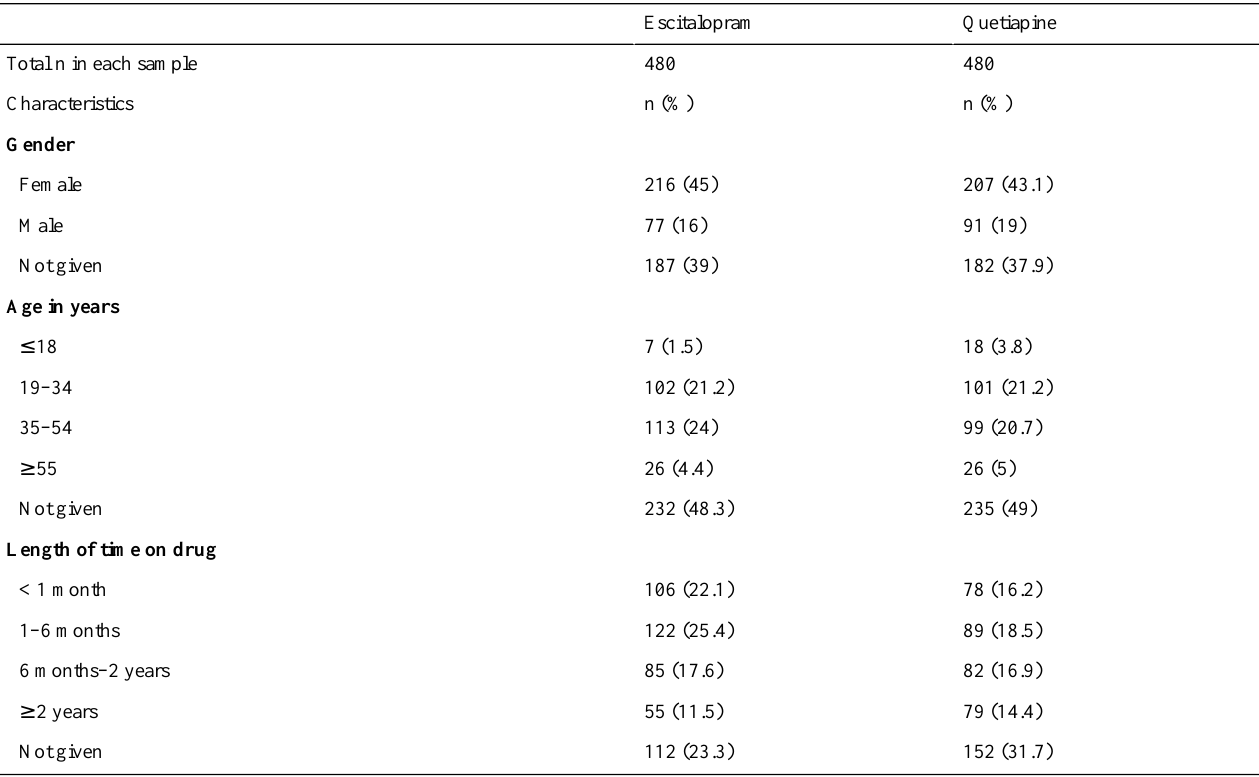
Table 3. Consumer characteristics according to drug